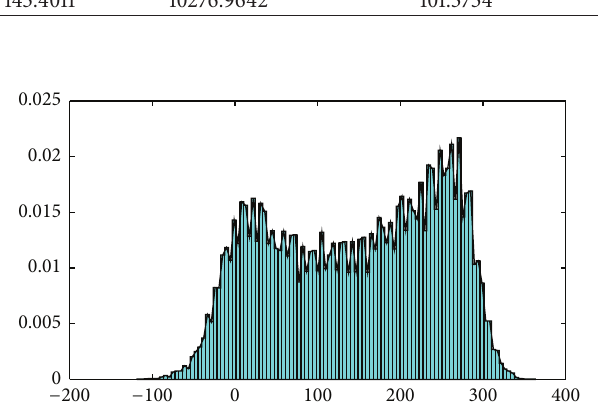
Figure 3: The distribution of daily average temperature of Zhengzhou (1951–2013).